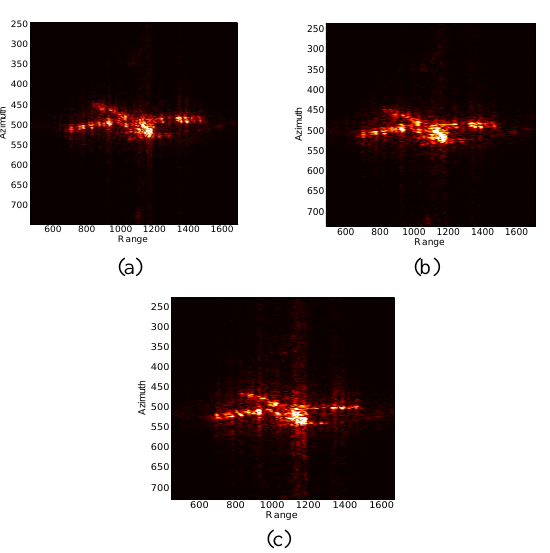
Figure 3 (a) image obtained by the classic method; (b) image obtained by conducting MTRC on (a); (c) image obtained by the